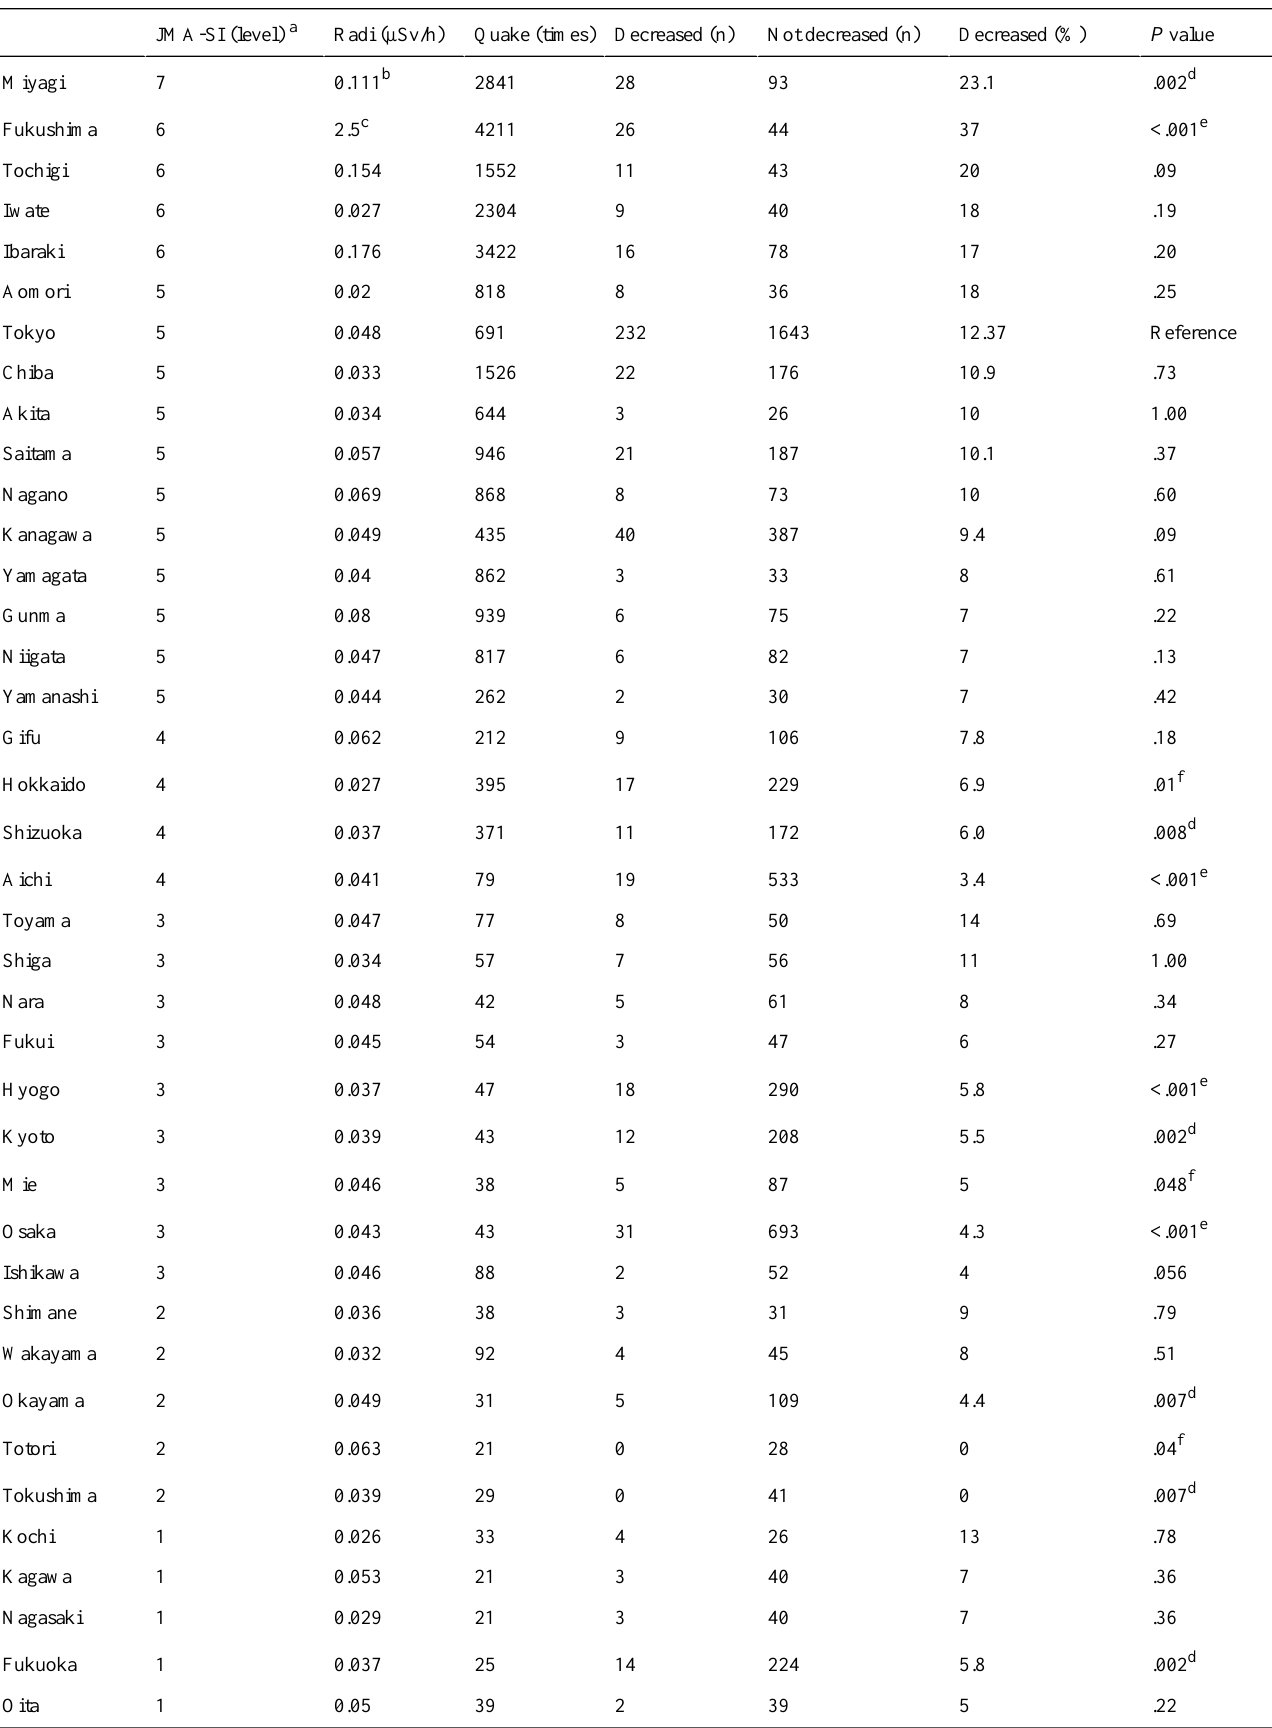
Table 2. Commuting location and the decreased self-perceived